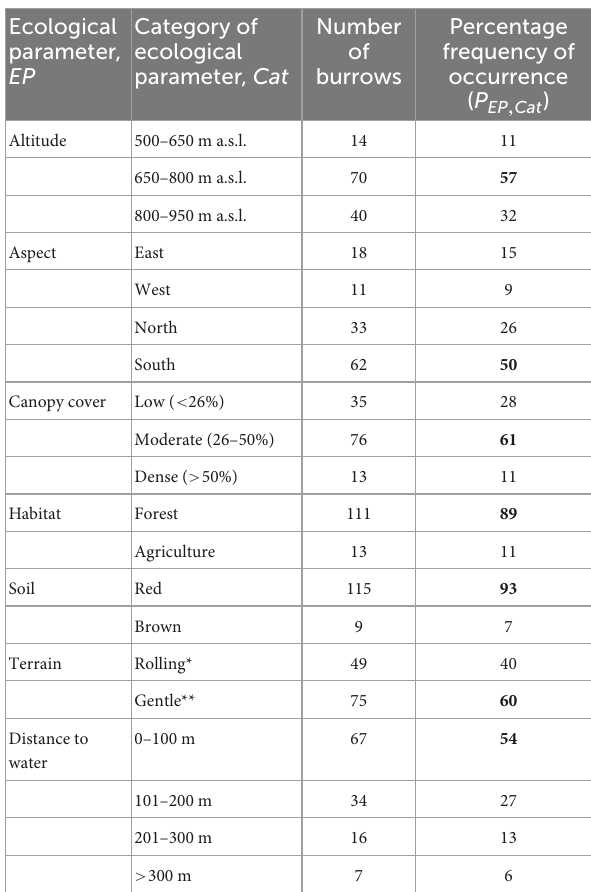
TABLE 1 Percentage frequency of pangolin burrows recorded for the seven ecological parameters measured in the area studied; for each category, the number of burrows and the percentage of the total number of burrows recorded in the area studied, the most often recorded are in